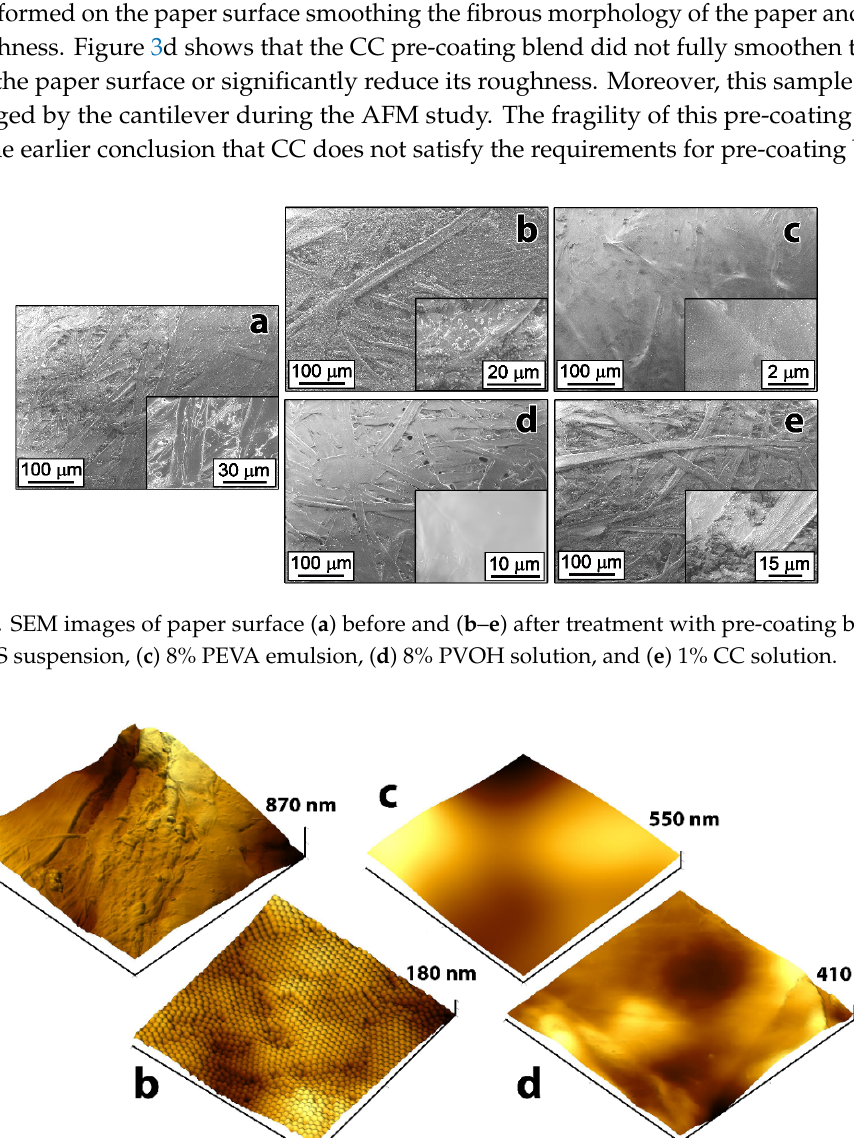
Figure 3. Three-dimensional AFM images of paper surface ( a ) before and ( b–d ) after treatment with pre-coating blends: ( b ) 8% PEVA emulsion, ( c ) 8% PVOH solution, and ( d ) 1% CC solution.